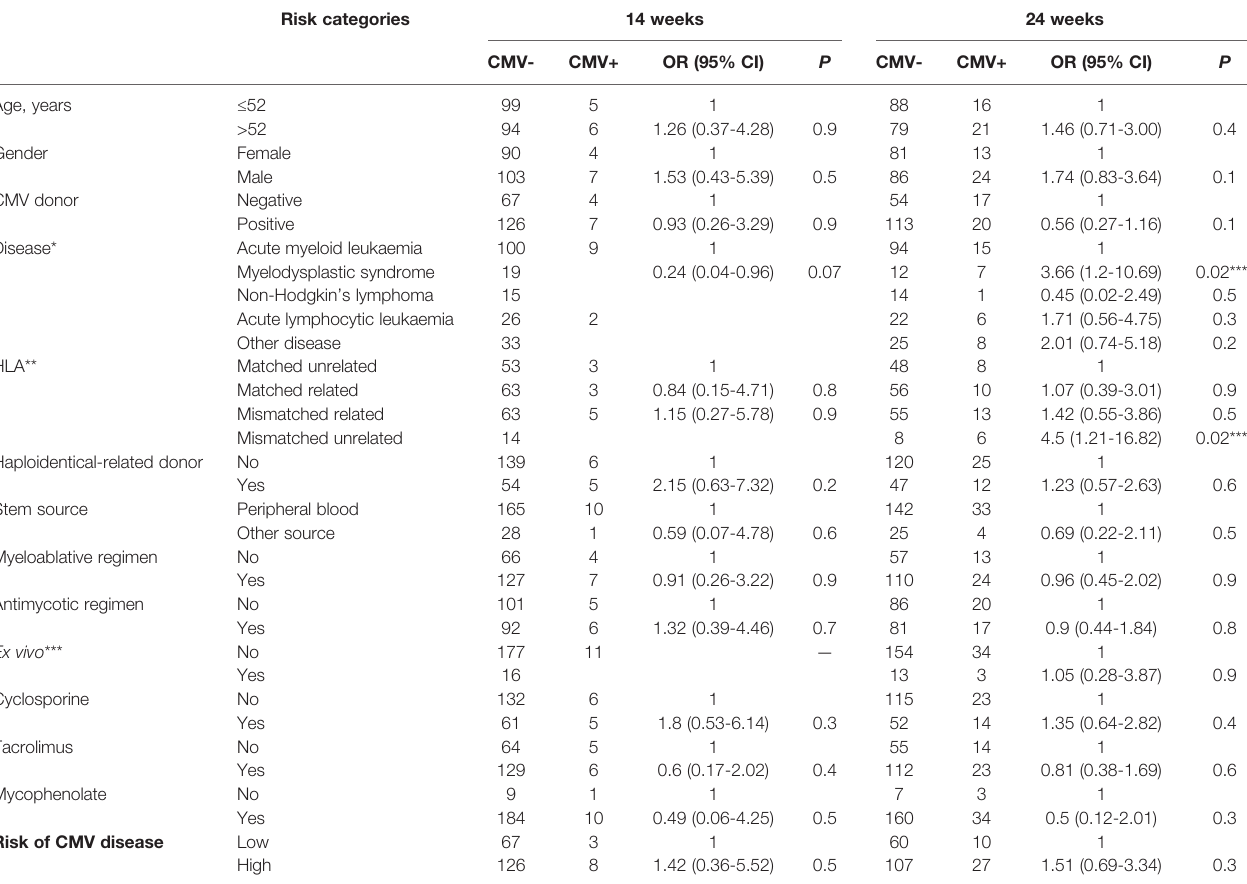
TABLE 5 | Univariate logistic regression analysis of CMV infection through fi rst 100 days and through 168 days by baseline characteristics. Risk categories